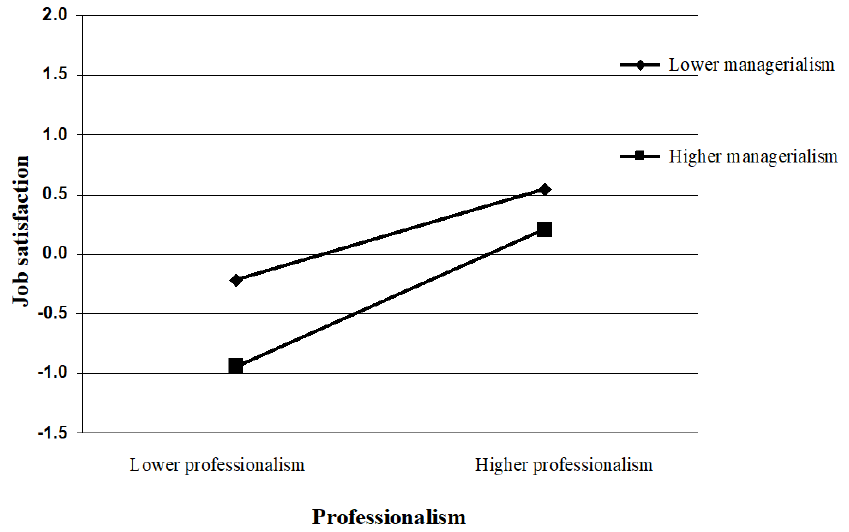
Figure 3. Moderating role of managerialism in the relationship between professionalism and job satisfaction.